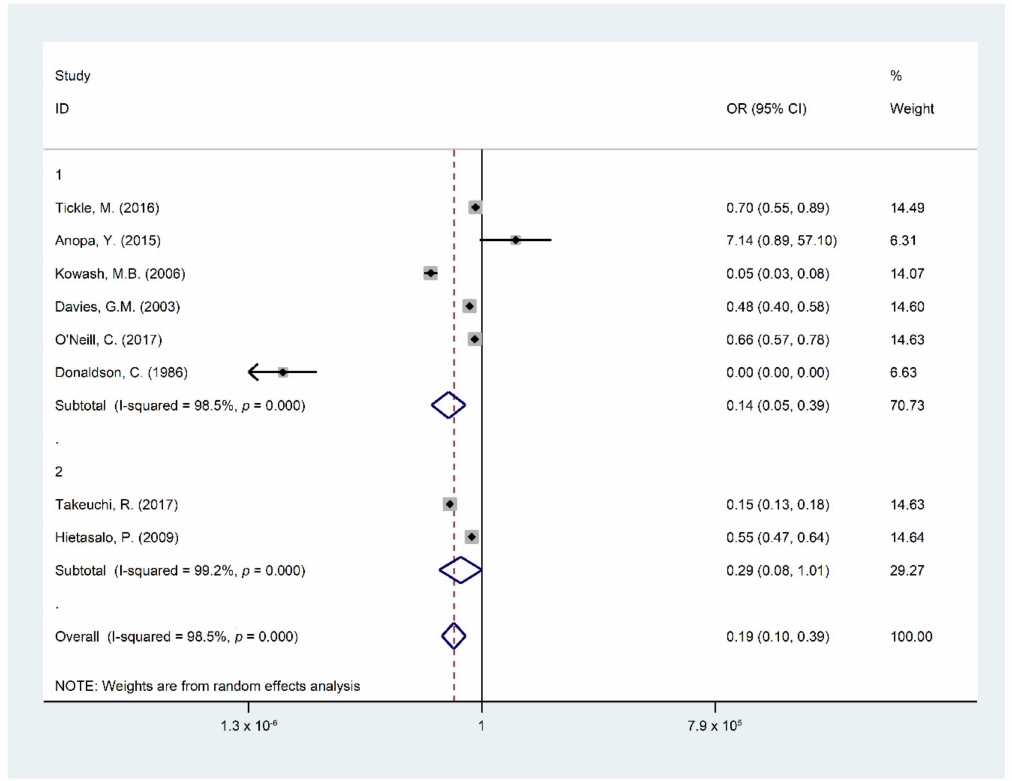
Figure 4. Forest plot of DMFT / S by children age group: 1 as (Age > 6) and 2 as (Age ≤ 6).